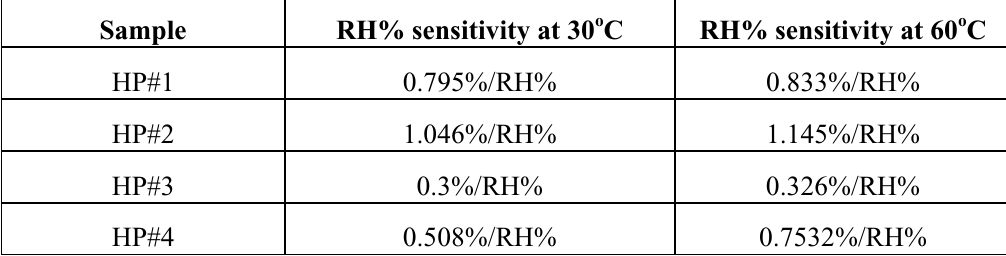
Figure 14. Humidity Sensitivity Curves for In 60 o C. Table 5. Relative humidity (%) sensitivity of each In sample, produced at high vacuum pressure, at 30 o C and 60 o